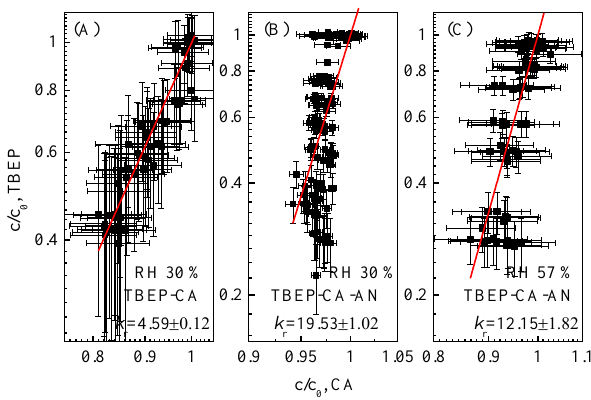
Figure 6. Comparison of the relative rates for internally mixed (a) TBEP-CA and (b) TBEP-CA-AN at 298K and (30 ± 3)% RH, and (c) TBEP-CA-AN at 298K and (57 ± 2)% RH.